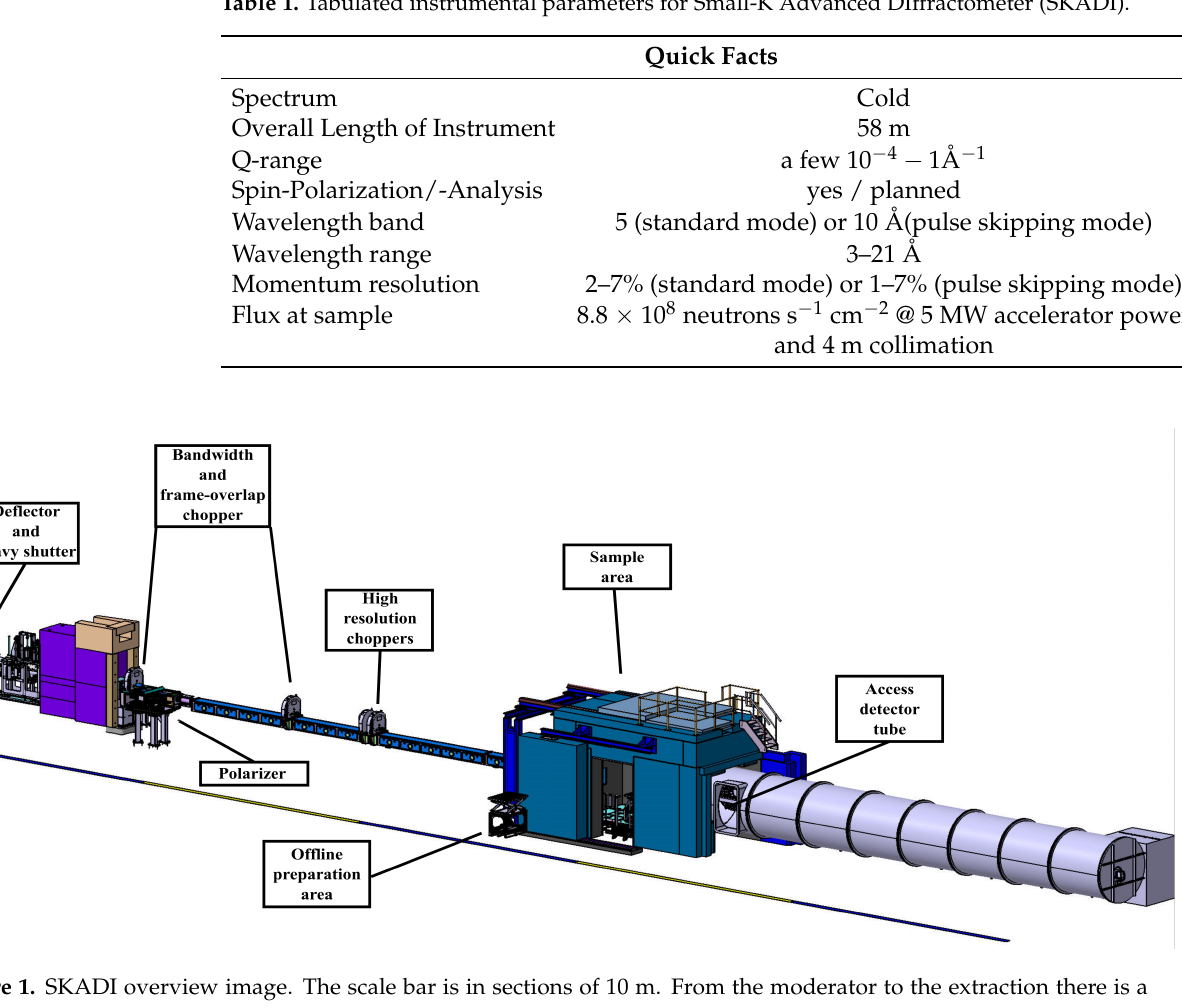
Figure 1. SKADI overview image. The scale bar is in sections of 10 m. From the moderator to the extraction there is a 2 m free flight path up to the neutron extraction. Inside the bunker, there is the neutron extraction of a double deflector type (see Section 2.1). This section also includes the heavy shutter, which vertically replaces the last section of neutron guide with an absorption block. The bunker wall is located between 11 and 15.5 m. Directly outside the bunker wall is the polarizer housing with an integrated chopper. Inside the collimation (from the bunker wall to the sample area), there is a other chopper disk at 22.85 m and the infrastructure for including two high resolution choppers further downstream. The collimation feeds into the sample area with the complete infrastructure for mounting the different setups for sample environments. The detector tube is directly attached to the sample area. The shielding is removed for better